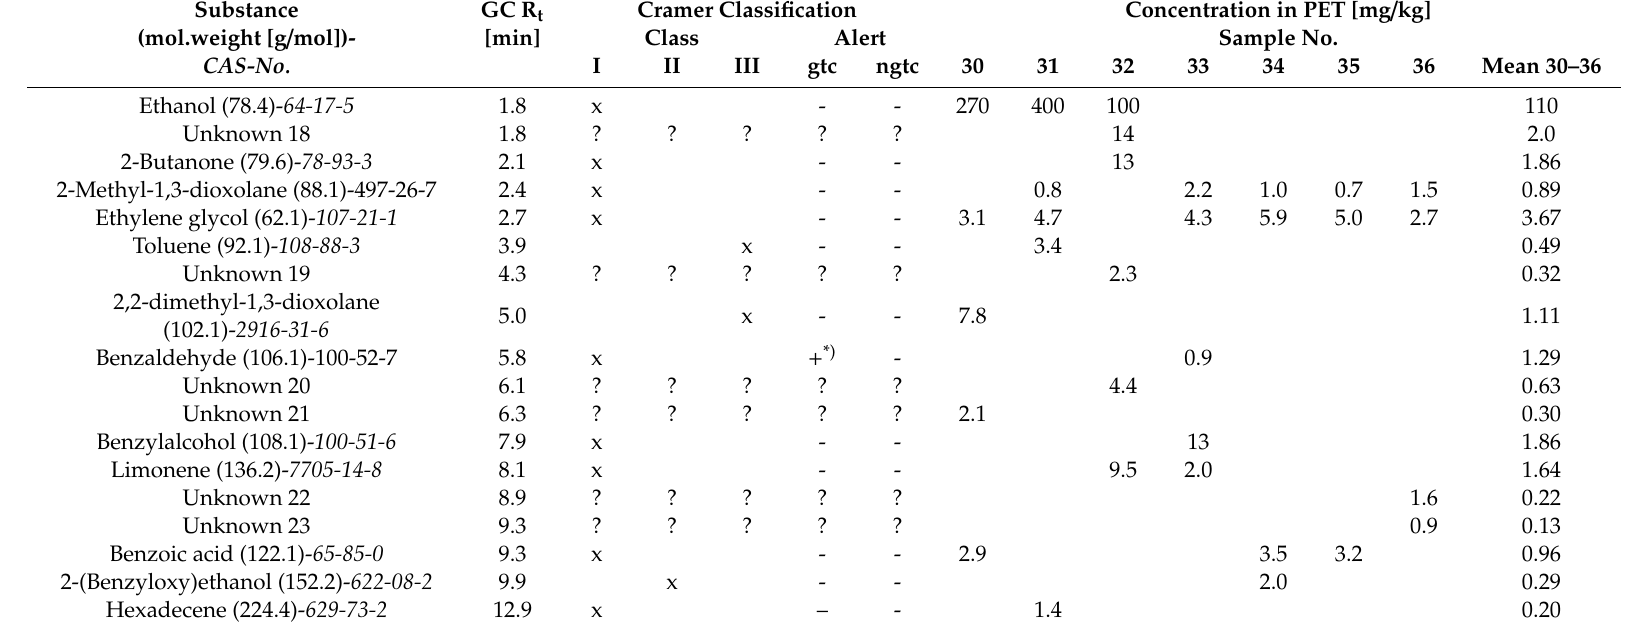
Table 6. Substances found in PET bottles originally used for shower gel or liquid soap products. Substance GC R t Cramer